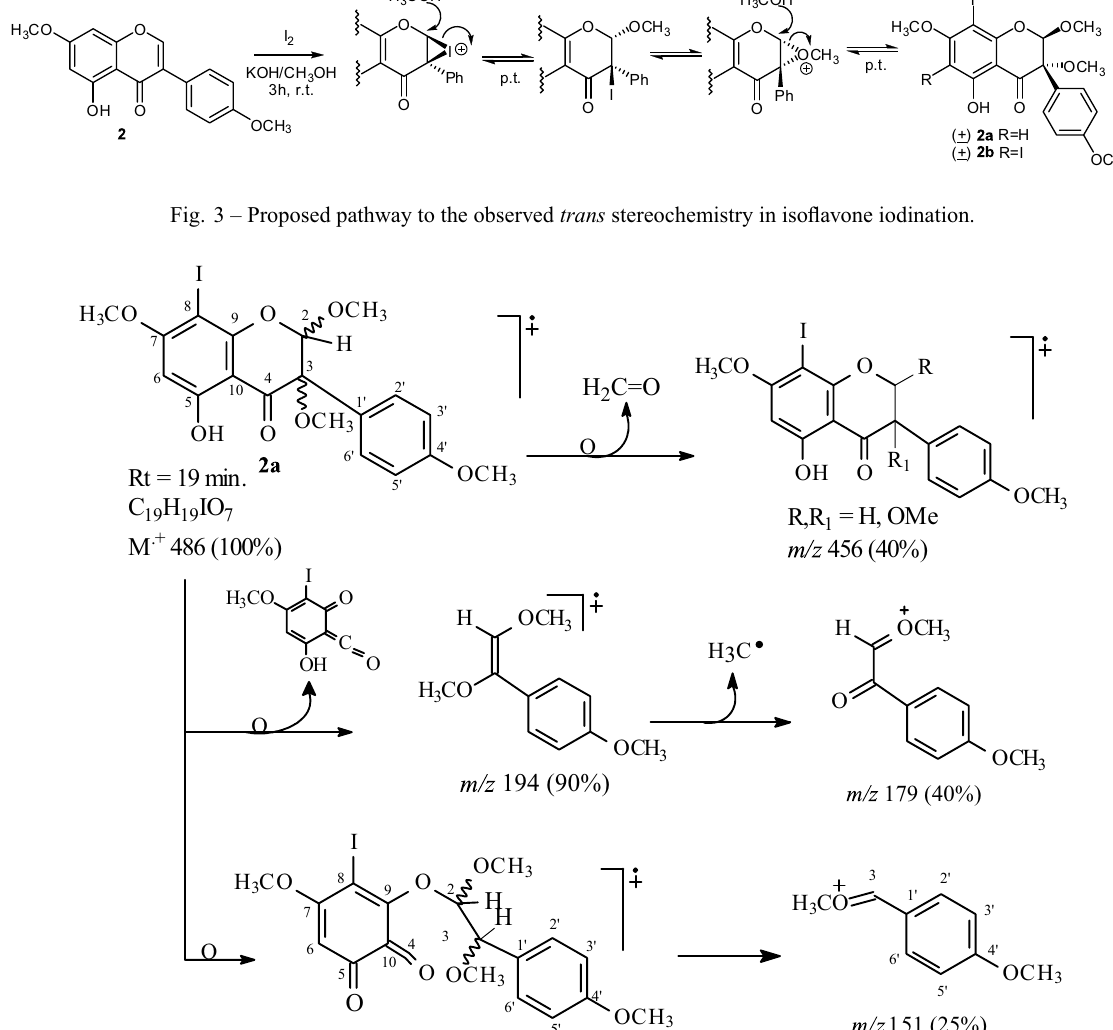
Fig. 4 – Proposed fragmentation patterns for 2a (only peaks classified as